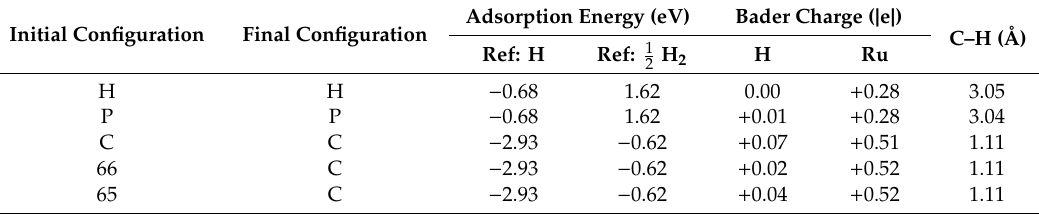
Figure 5. ( a ) Optimized structure of Ru@C 60 , ( b ) bond distances and ( c ) charge density plot of encapsulated configuration. Table 4. Final configurations of a single H atom adsorbed on the surface of Ru-encapsulated C 60 , adsorption energies with respect to gas phase hydrogen atom and diatomic molecule, Bader charges on the Ru and H atoms and shortest C–H bond distances in the relaxed configurations.